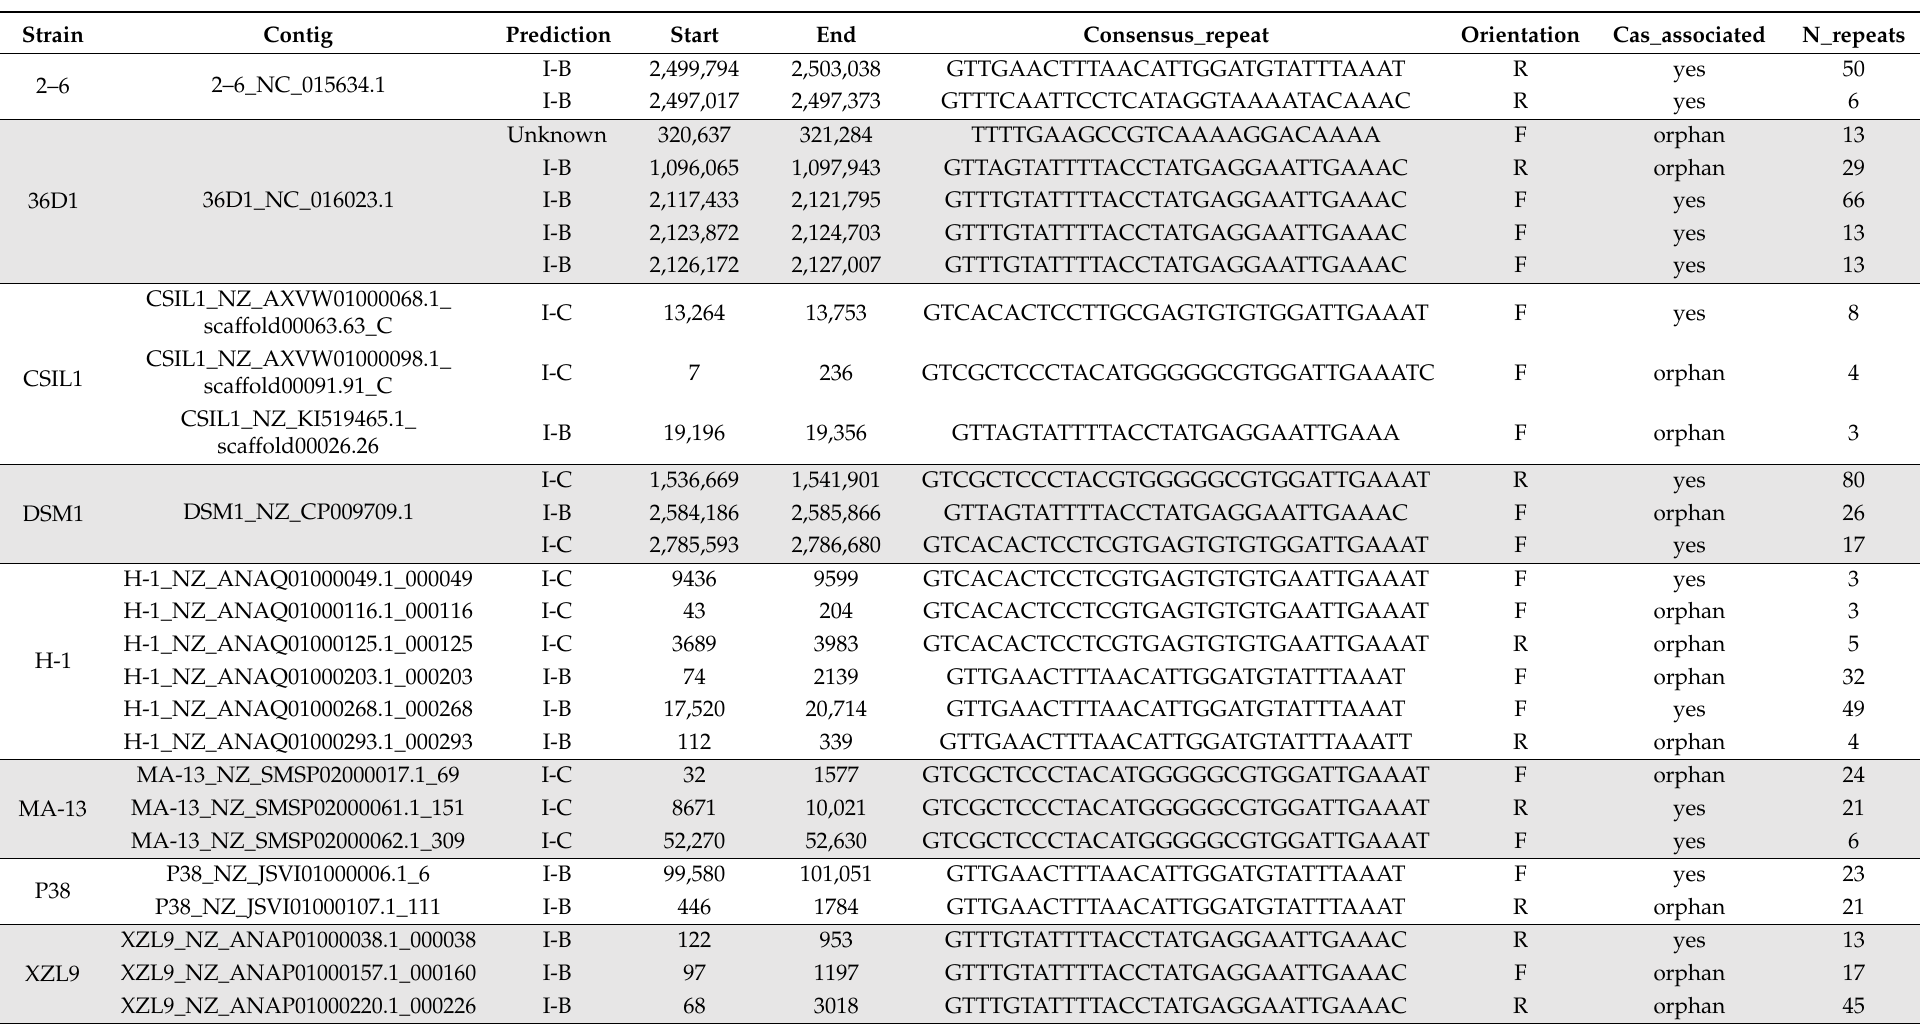
Table 4. CRISPR arrays in the W. coagulans